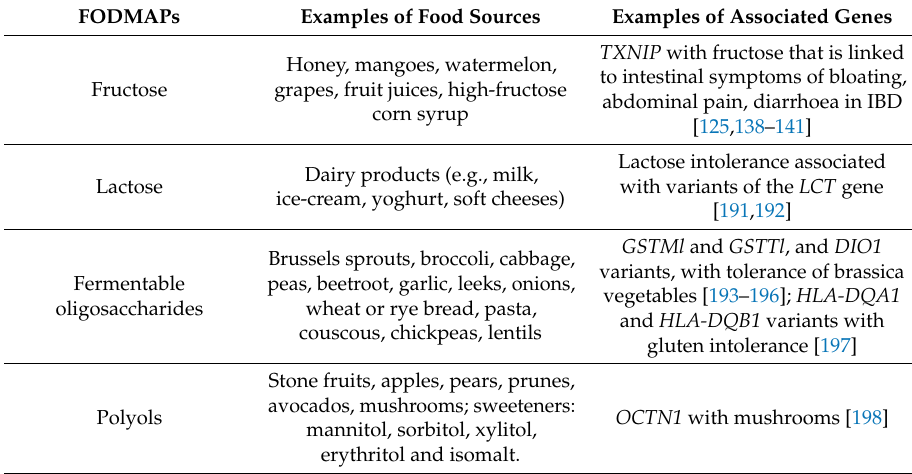
Table 4. Sources of foods high in fermentable oligo-, di- and mono-saccharides and polyols (FODMAPs)